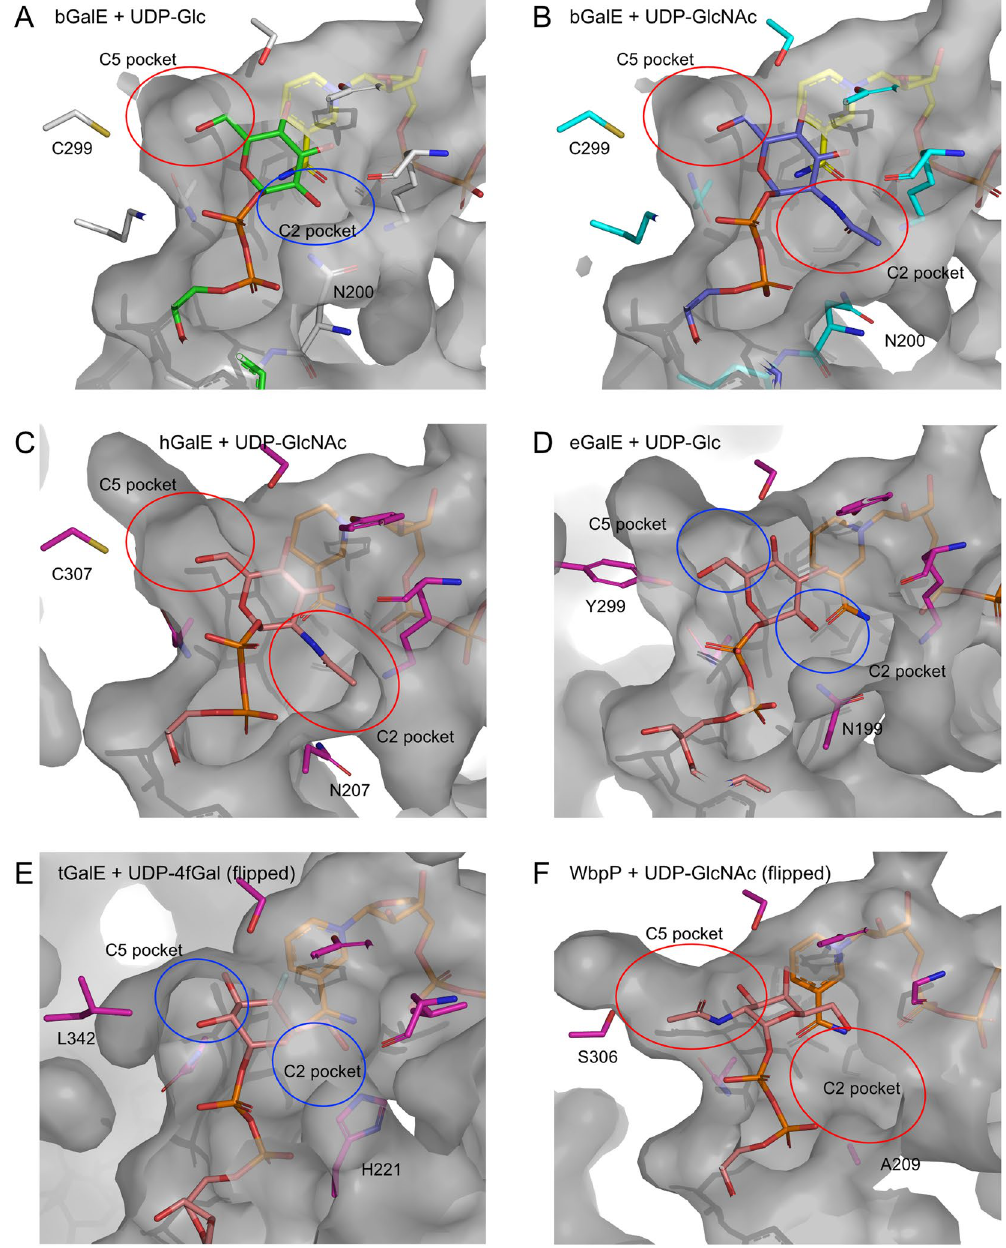
Figure 7. Surface presentation of the UDP-sugar binding site in GalEs. ( A ) bGalE + UDP-Glc, ( B ) bGalE + UDP-GlcNAc, ( C ) hGalE + UDP-GlcNAc, ( D ) eGalE + UDP-Glc ( E ) tGalE + UDP-4fGal, and ( F ) WbpP + UDP-GlcNAc are shown. Color codes and PDB IDs are as described in Figs 4 and 6. The C5 and C2 pockets are shown as red or blue circles for large or small pockets, respectively. The probe radius for surface calculation was 1.4